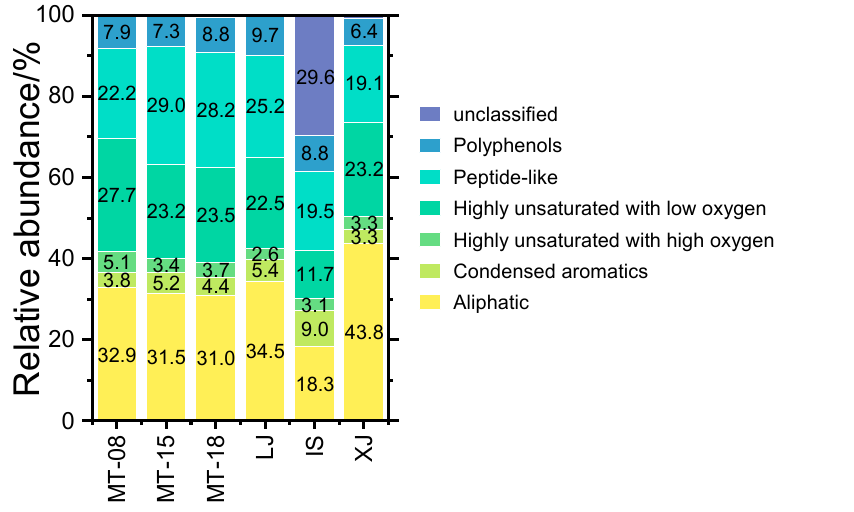
Figure 5. Bar diagrams showing the contribution of major compound categories in the different Baijiu samples revealed by the combination of ESI+ and ESI − mass spectrometry analysis. As plotted in Figure 6, the compounds of trace components in sauce-flavor Baijiu were dominated by CHO class compounds, with the relative abundance ranging from 43.0% to 56.8%, followed by CHNOS, CHOS and CHNO classes. The distribution for other classes was 19.4–32.0% for CHNOS, 10.2–15.4% for CHOS, and 7.3–15.6% for CHNO compounds, respectively. Considering the highest relative abundance of the CHO class, which represents the major portion of the samples, the relationship between carbon number and DBE for the CHO class compounds was plotted in Figure 7. Such diagrams were used to obtain further compositional characteristics of the sauce-flavor Baijiu and the corresponding variations that existed among them. The carbon numbers of different samples were mainly distributed from 6 to 40. MT, LJ and XJ had similar characteristics, with oxygen numbers mainly ranging from 1 to 8 and DBE distribution between 0 to 8 and 13 to 16. Lower DBE values have lower carbon numbers, whereas higher values have higher carbon numbers. IS had a wide range of oxygen content, from 1 to 18, and DBE values ranged from 0 to 6. The oxygen content is higher for low DBE values, whereas the higher the carbon number the higher the oxygen content is. To better illustrate the major contents in Baijiu, the top 10 compounds with the highest abundances in each of the six samples were listed in Table 3. For MT, the highest abundance was identified to be CHNOS class compounds, and in addition, CHO class compounds were more abundant in other liquors.